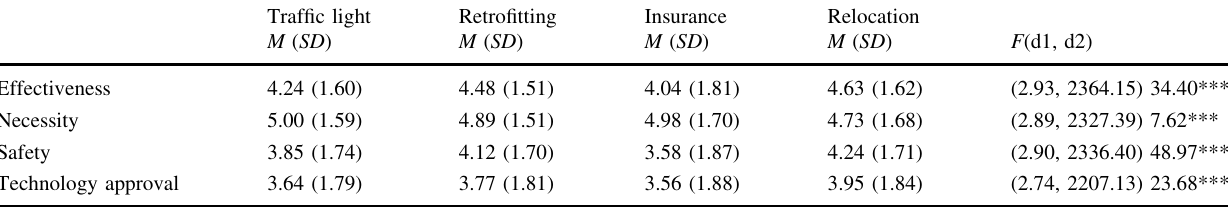
Table 2 Risk mitigation perception with four different criteria (within subject design, N = 807)